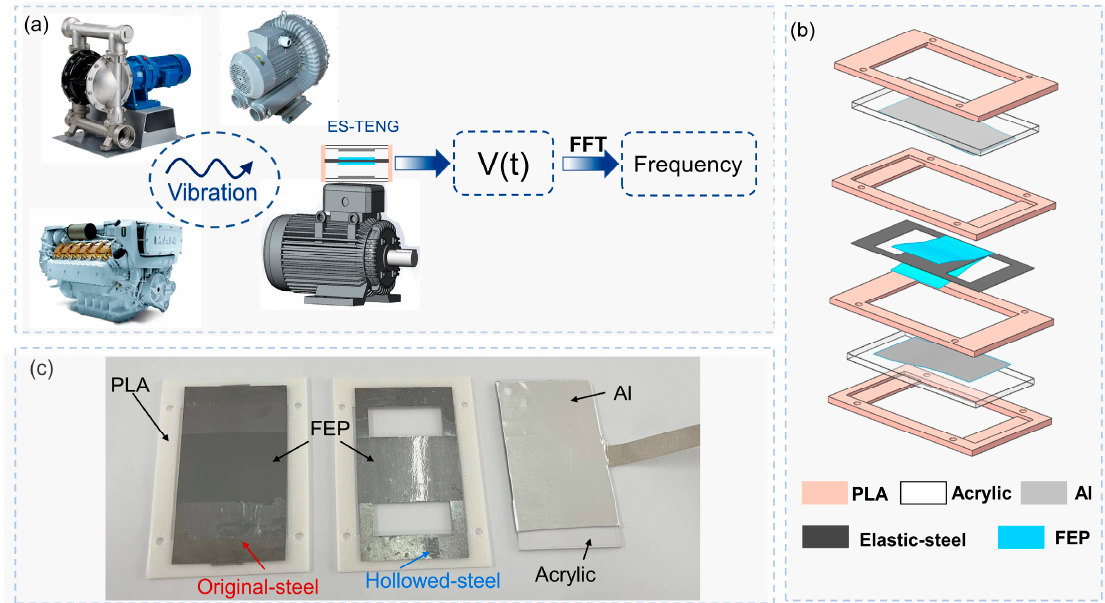
Figure 1. Application scenario and specific structure of the elastic steel triboelectric nanogenerator (ES − TENG) sensor. ( a ) Application scenario of ES − TENG; ( b ) explosive view of ES − TENG; ( c ) photograph of ES − TENG.